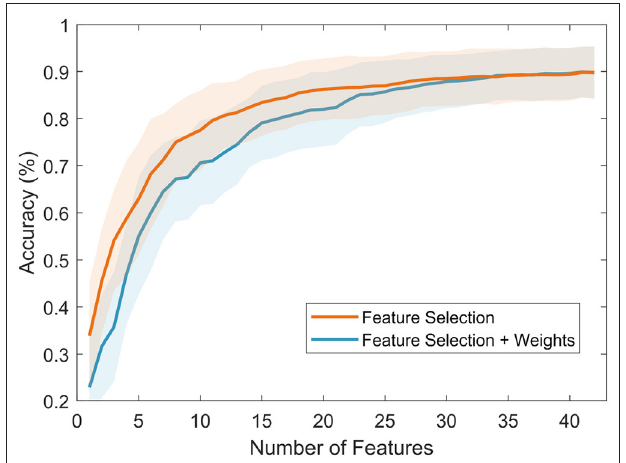
FIGURE 8 | Classification results using the features ranked after the feature selection (using JMI) process (in orange) and after the feature selection + weights process (in blue).